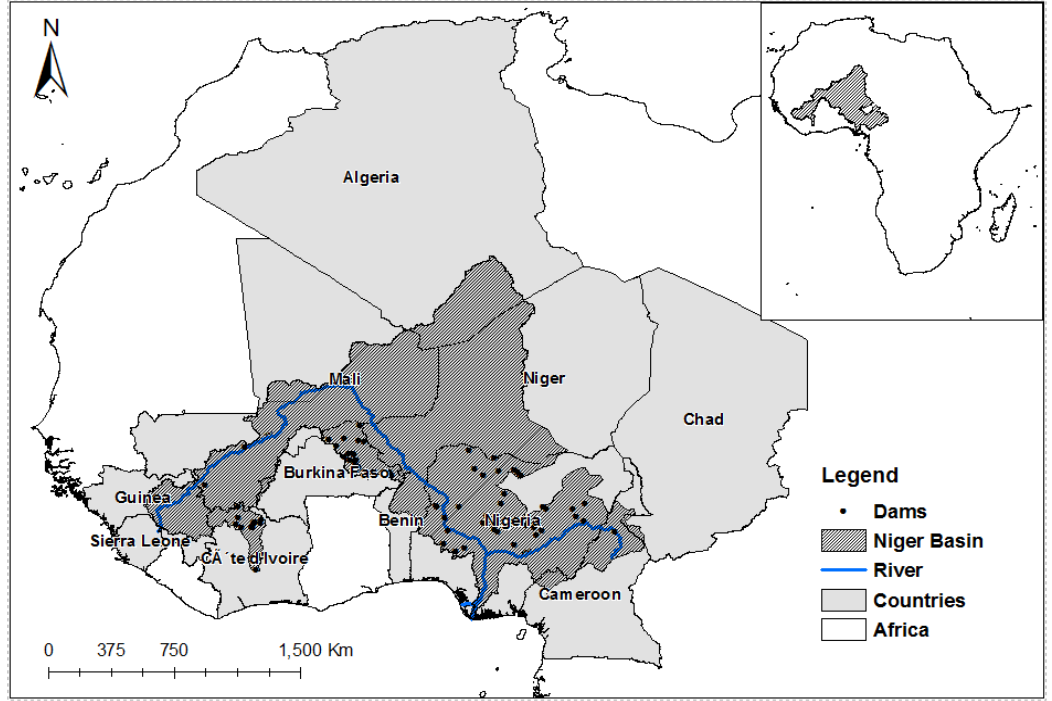
Figure 11. Map of the transboundary Niger River Basin, showing constituting countries and Dams.